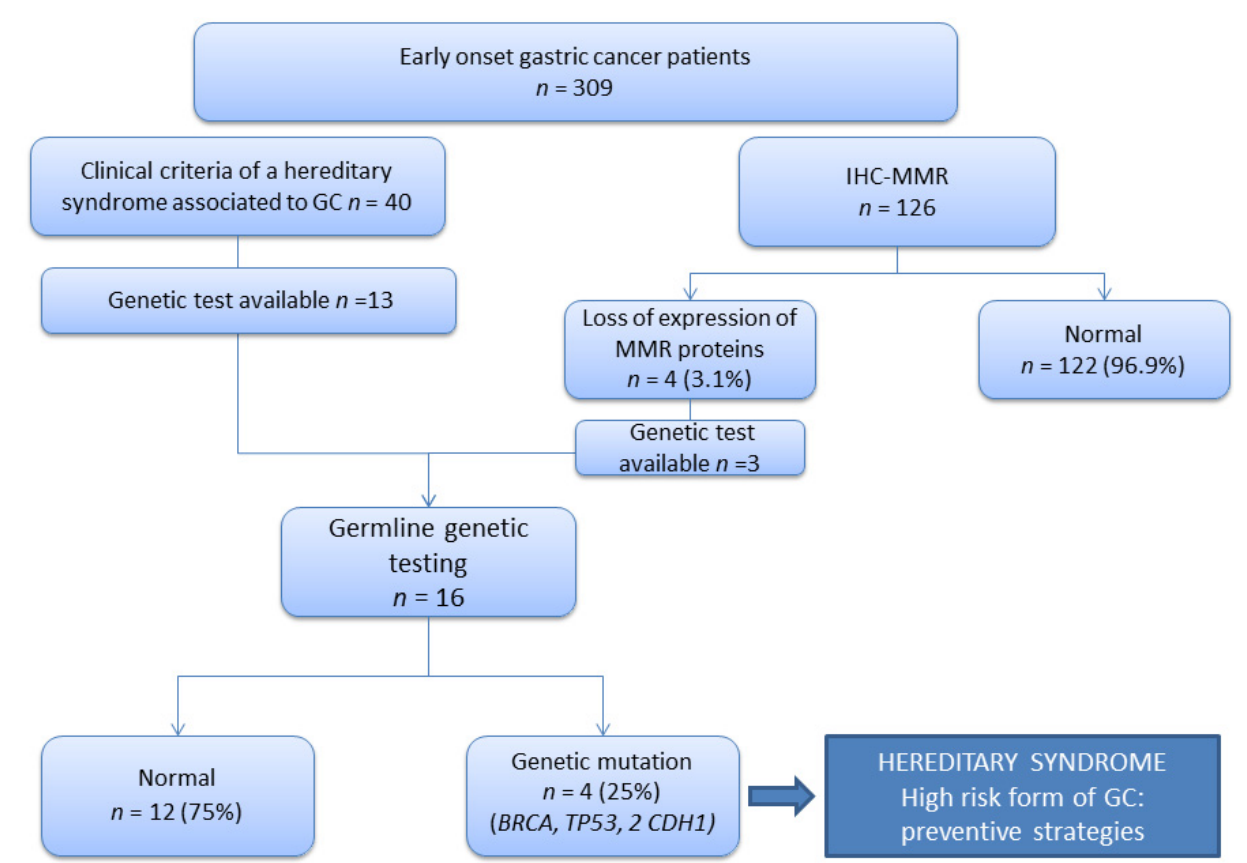
Figure 2. Scheme followed summarizing the results of IHC-MMR and germline genetic testing. Regarding survival, with a median follow up of 7.6 years (IQR 17-38), a 5-year survival rate of 32.6% was observed, with a significant difference based on clinical stage (stage I–II 87% vs. stage III–IV 11.3%, p = 0.0001; Figure 3), and diffuse histology was associated with worse prognosis ( p = 0.019); no differences in gender, age, family history of GC, H. pylori infection, smoking or alcohol consumption, tumor differentiation grade, or MMR-IHC were detected.